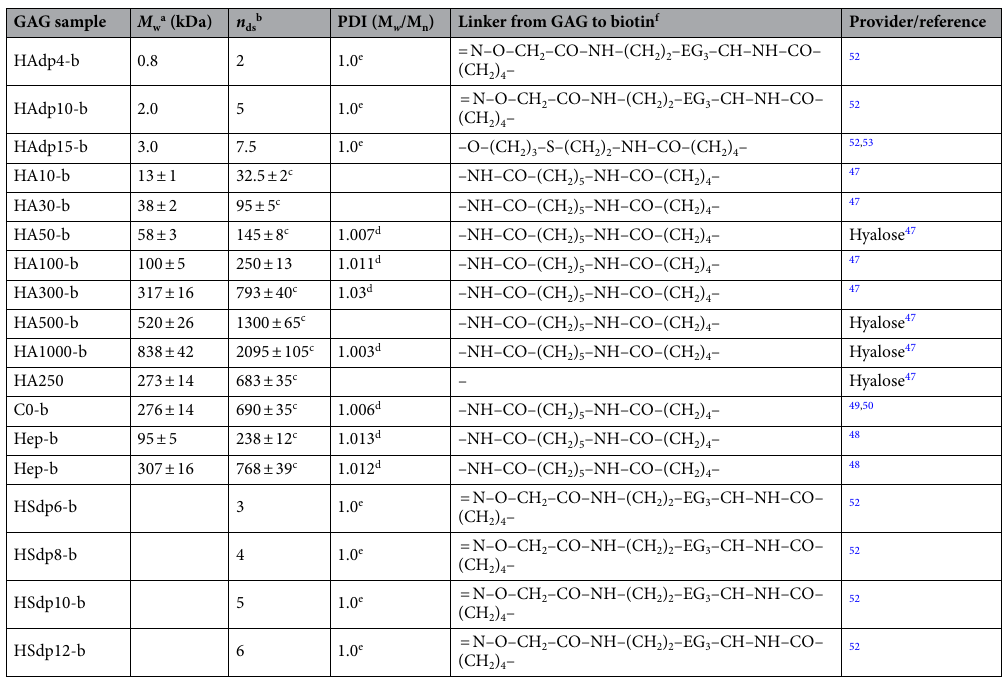
Table 1. Quasi-monodisperse and size-defined GAG samples used in this study. a M w as per manufacturer’s specifications (excluding the mass of the biotin and linker). Based on the polydispersity index (PDI) for most polysaccharides, errors for all size-defined GAG polysaccharides were conservatively estimated to ± 5%. b Number of disaccharides per chain, n ds . c Calculated from M W and a molecular mass of 400 Da per disaccharide. d PDI for polysaccharides determined by SEC–MALLS, as per manufacturer’s specification. e Oligosaccharides were purified by size, and are assumed to have a PDI close to 1. f Biotin was conjugated to C of N -acetylglucosamine (for HA-b and HS-b) and N -acetylgalactosamine (for C0-b) at the reducing end of the GAGs; EG ethylene glycol.